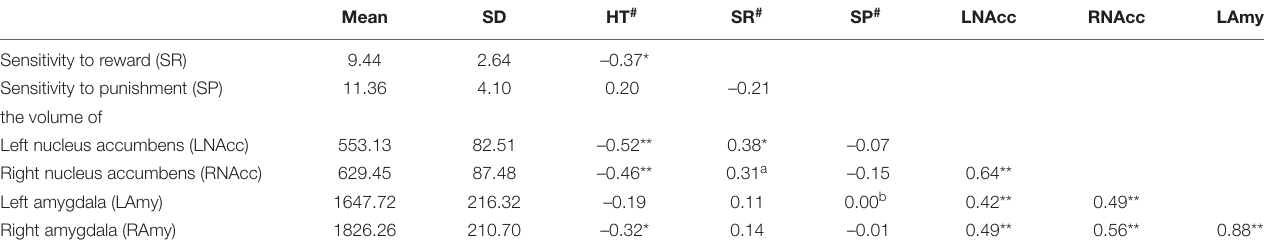
TABLE 1 | The correlation between holistic thinking tendency, sensitivity to reward and punishment, the volume of bilateral nucleus accumbens, and amygdala ( n = 39). Mean SD HT # SR # SP # LNAcc RNAcc LAmy